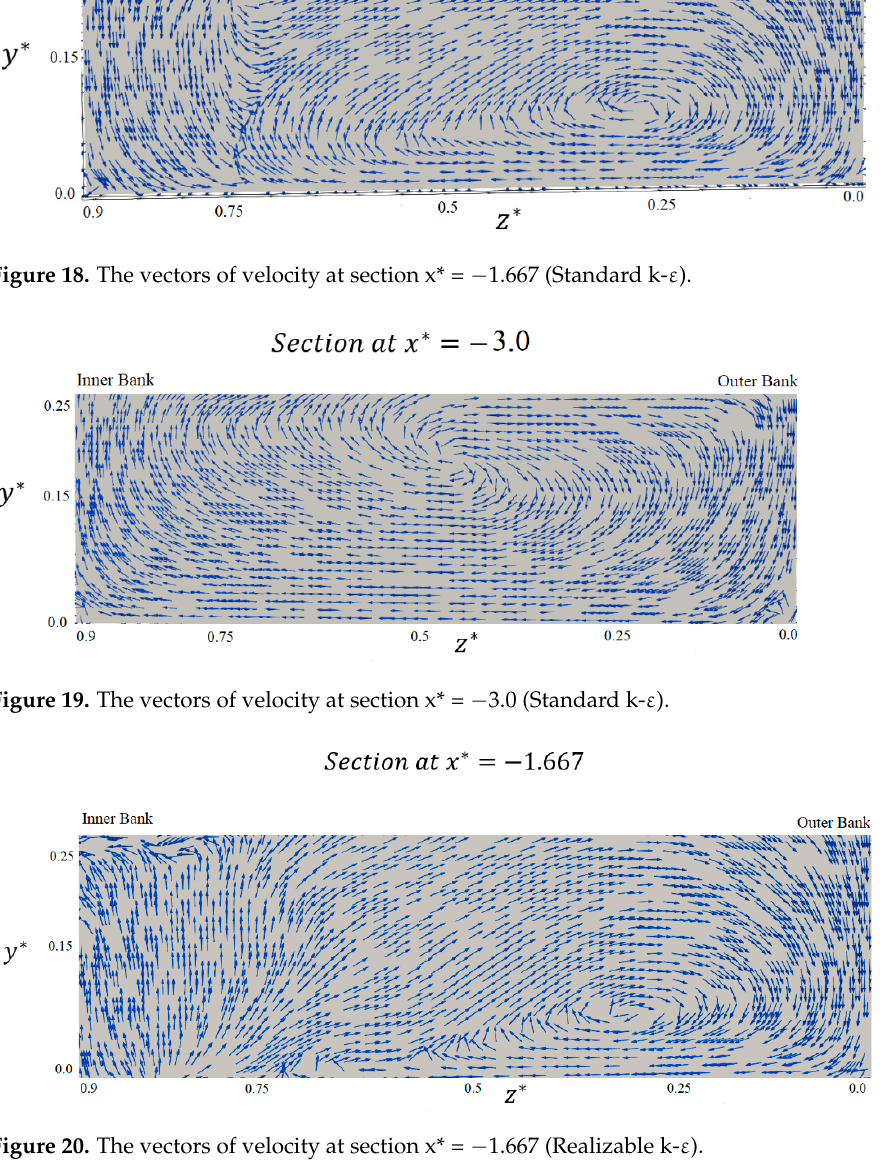
Figure 21. The vectors of velocity at section x* = − 3.0 (Realizable k- ε ). 3.4.4. Longitudinal Velocity Distribution The simulated results for longitudinal velocity distribution were compared with the experimental data of Weber et al. [19] as shown in Figure 22 which represents a longitu- dinal section close to the water surface, and the results seem reasonable. Immediately be- low the channel junction and along the wall adjacent to the junction there was a zone of low velocity which represents the separation zone. Rotation within the separation region is shown as a region with positive velocity. The highest velocities occur downstream of the junction towards the outer bank of the main channel as clarified by section x* = − 2.0 (Figure 23). The velocity patterns near the surface were distinctly different from the lon- gitudinal velocity contours near the bed. Additionally, the separation zone near the sur- face was larger in length and width. The size of the separation zone is different as well from top to bottom due to the branch channel flow entry angle. In the area near the sur- face, more recirculation occurred inside the separation zone. The higher velocities imme- diately downstream of the junction occurred near the bed which could be attributed to the entrance angle of the lateral flow. However, the maximum velocities are readjusted to be near the surface as the contracted zone is passed [19].